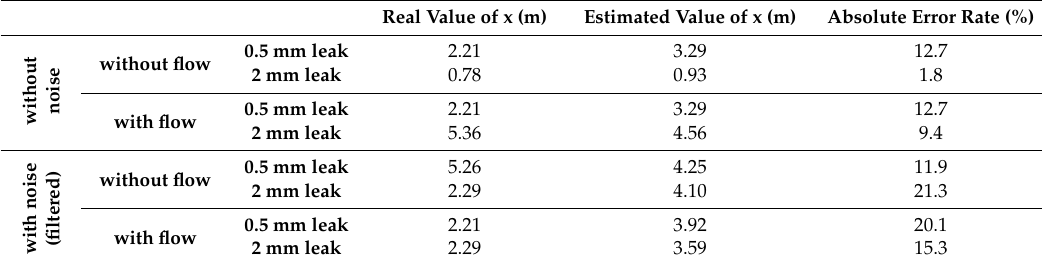
Table 6. Results from the Roth method for 8.5 m distance between the